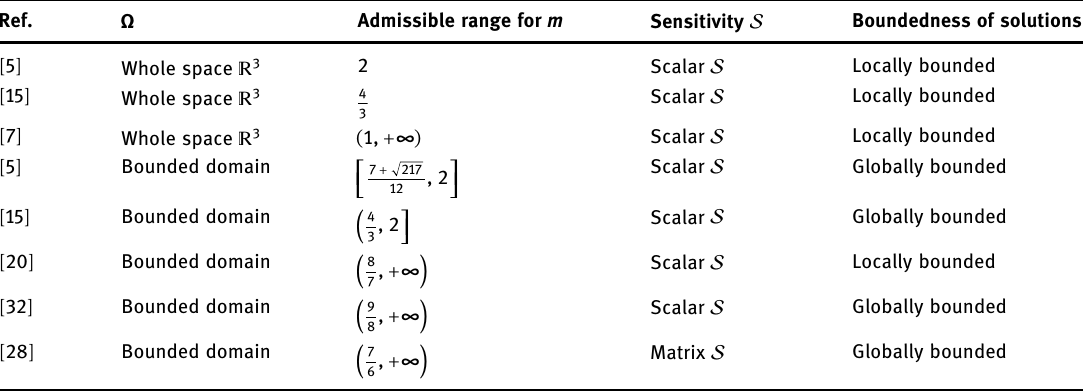
Table 1: On the 3D chemotaxis - Stokes system with porous medium - type cell di ff usion